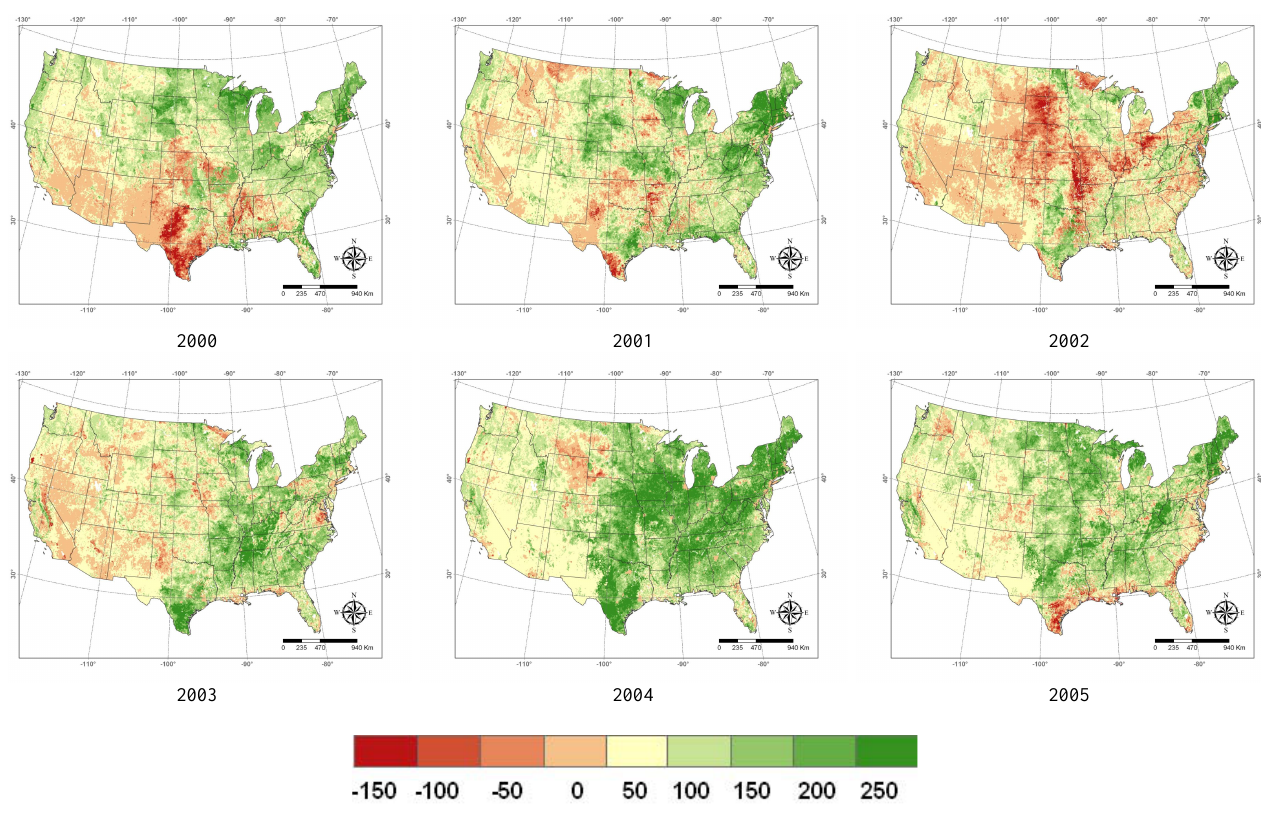
Fig. 5. Annual average SAT-TEM estimated NEP across the conterminous United States for each year in 2000–2005. Positive values represent carbon sink while negative values represent carbon source. Units are gCm − 2 yr − 1